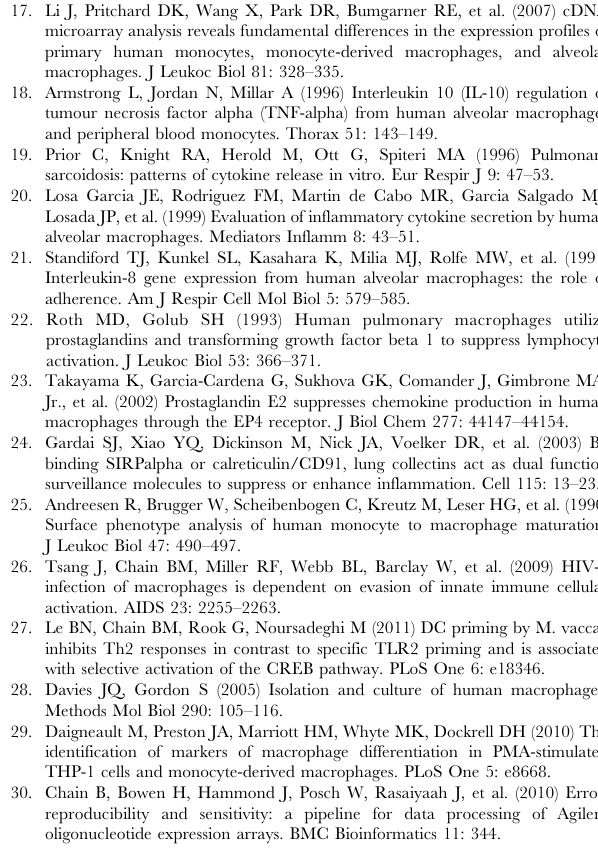
Table S3 Summary of AM enrichment and culture methods. Recently published studies involving alveolar